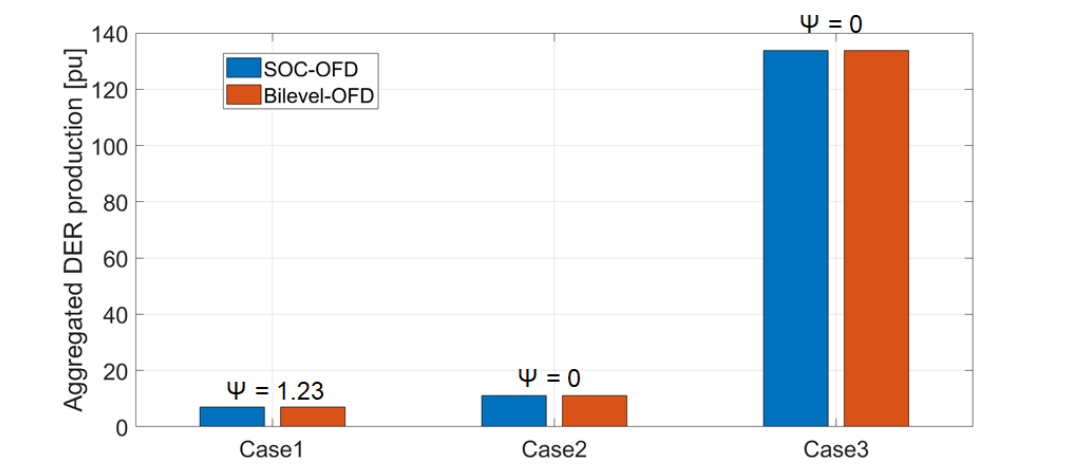
Figure 2. Aggregated production of DER buses, and curtailment level ( Ψ ), calculated by SOC-OFD model (the blue bars) and bi-level-OFD model (the red bars) for the three